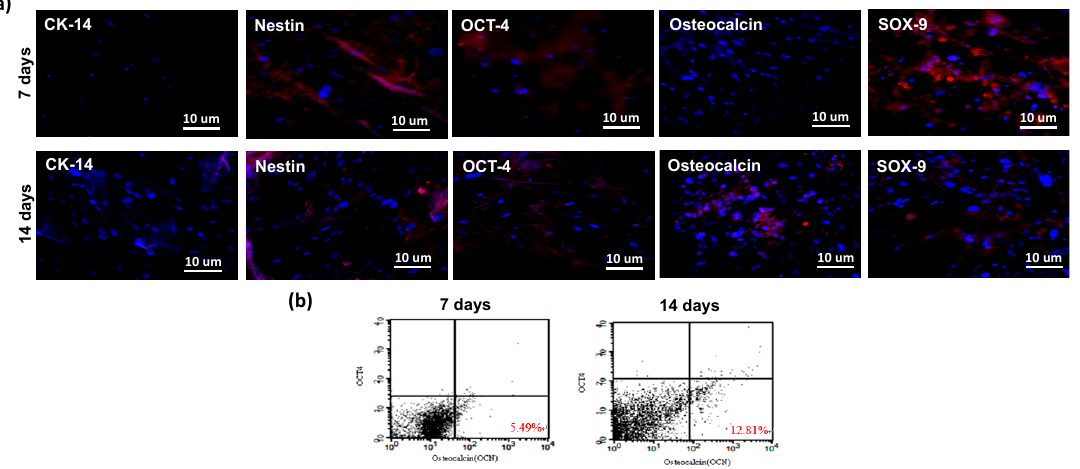
Figure 4. Immunofluorescence staining of human adipose stem cells (hASCs) cultured on the gelatin scaffold for 7 and 14 d. Nuclei counterstained with Hoechst 33342 are indicated in blue. ( a ) Multilineage differentiation of hASCs; ( b ) flow cytometric analysis of the osteocalcin marker.